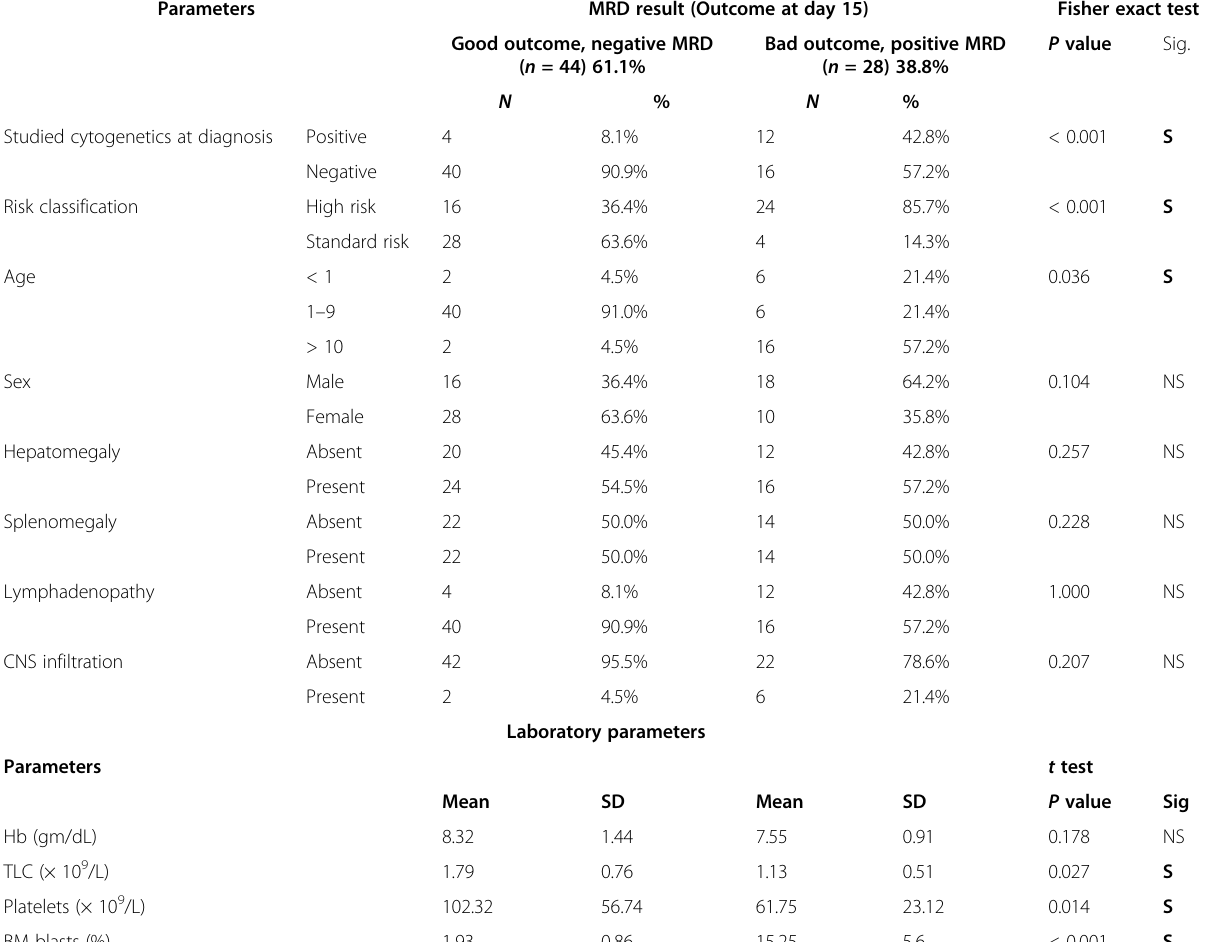
Table 4 MRD study of all patients on day 15 regarding studied parameters